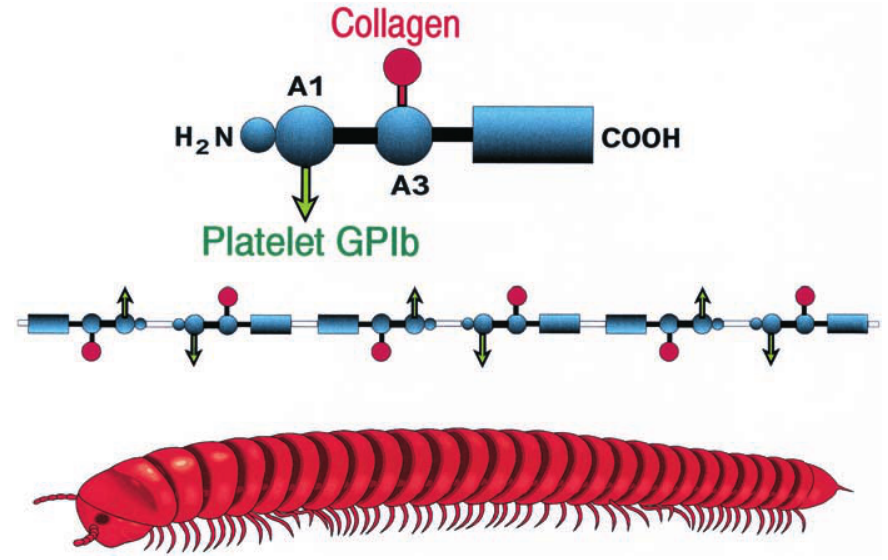
Schematic model of vWF structure. Binding sites for platelet glycoprotein Ib and collagen, involved in the initial event of primary hemo- stasis, are situated on the A1 and A3 domains, respectively. Multiple interactions of repeating binding sites with collagen and platelet recep- tors are dramatically increased in highly poly- meric forms of vWF synthesized in endothelial cells and megakaryocytes. Only the large vWF multimers are capable of supporting platelet adhesion to the denuded subendothelium of an injured blood vessel under high shear forces encountered in the circulation. The millipede whose multiple legs help to resist its gravity under unfriendly weather conditions invented a similar solution of the adhesion